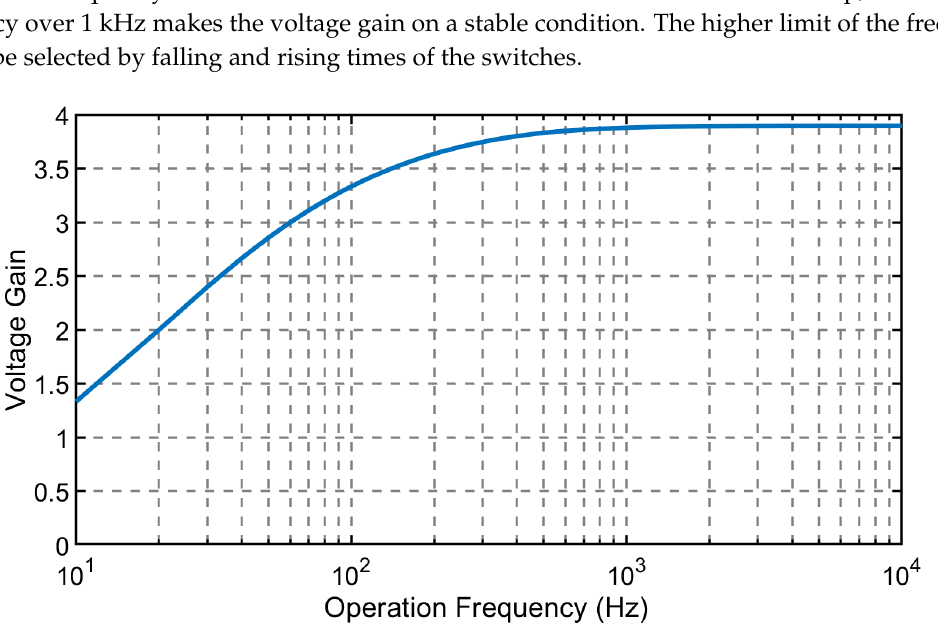
Figure 4. Voltage gain regulations at different